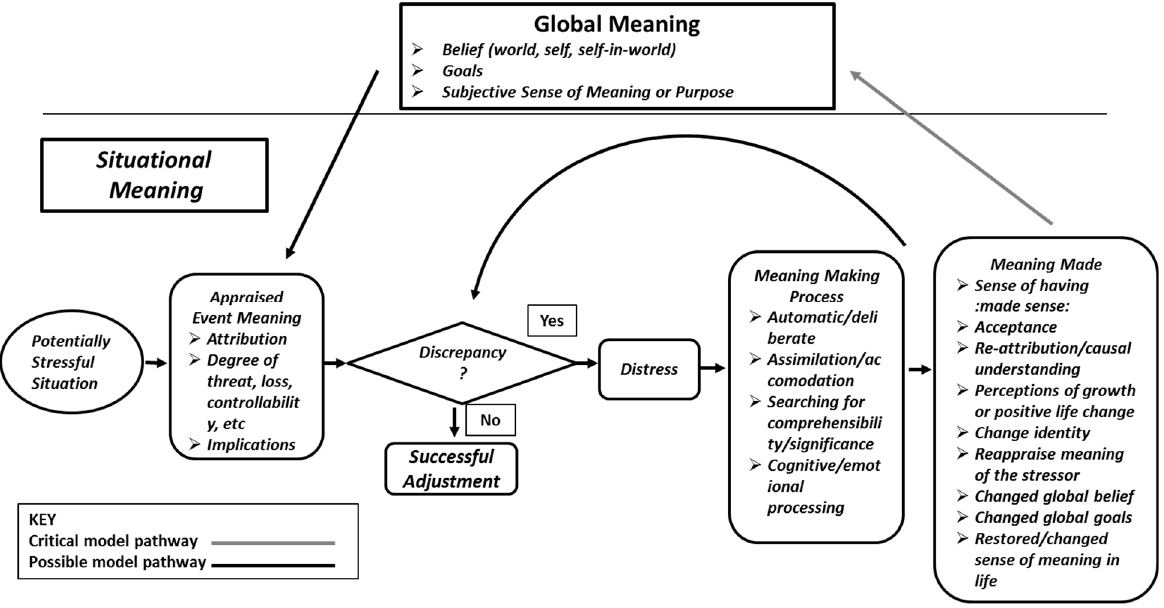
Figure 1. The meaning making model ([17], p. 258) .